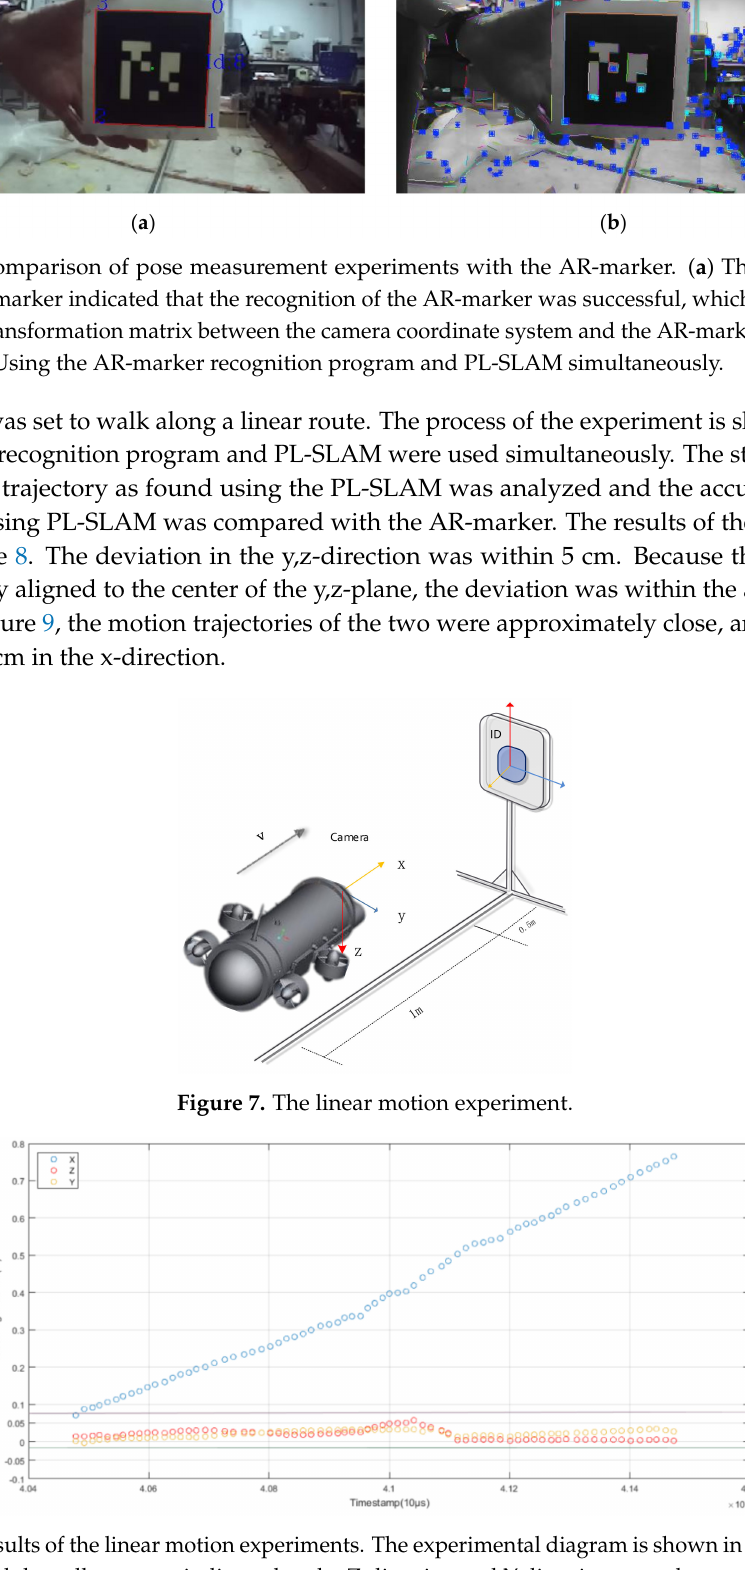
Figure 8. Results of the linear motion experiments. The experimental diagram is shown in Figure 7. The red curve and the yellow curve indicate that the Z-direction and Y-direction pose changes measured by PL-SLAM were small. The blue curve indicates that the change of the X-direction pose measured by PL-SLAM was proportional to